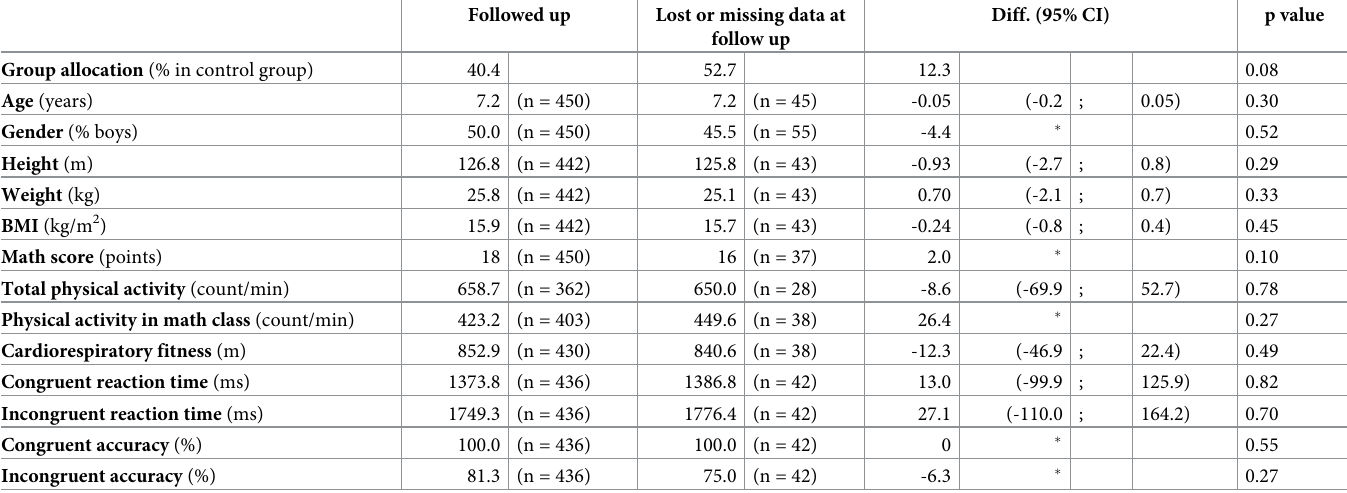
Table 2. Comparison of baseline characteristics of participants followed up at 9 months and those lost to follow-up or with missing data.